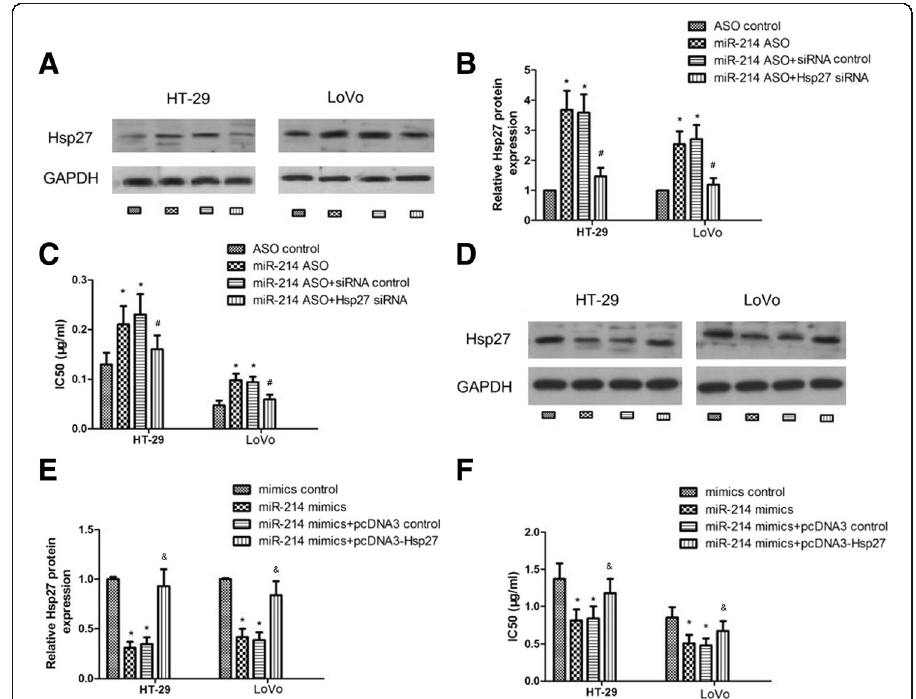
Fig. 5 Hsp27 blocks the effect of miR-214. a , b and c – HT-29 and LoVo cells were transfected with ASO control, miR-214 ASO, miR-214 ASO + siRNA control or miR-214 ASO + Hsp27 siRNA. Protein expression of Hsp27 was detected via western blot ( a and b ) and IC 50 values were detected using CCK-8 assays ( c ). d , e and f – HT-29 and LoVo cells were transfected with mimics control, miR-214 mimics, miR-214 mimics +pcDNA3 control or miR-214 mimics+pcDNA3-Hsp27.Protein expression of Hsp27 was detected via western blot ( d and e ) and IC 50 values were detected using CCK-8 assays ( f ). Data represent the means ± SEM from three independentexperiments. *compared to control, p < 0.05; # compared tomiR-214 ASO + siRNA control, p < 0.05; & compared to miR-214 mimics+pcDNA3 control, p <